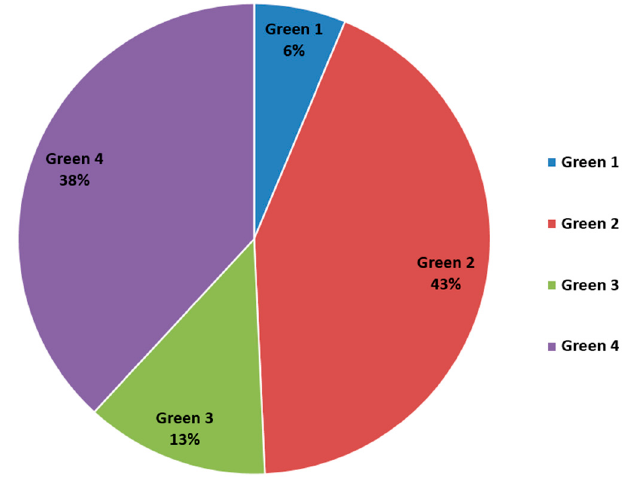
Figure 2. Certification status by G-SEED grade.